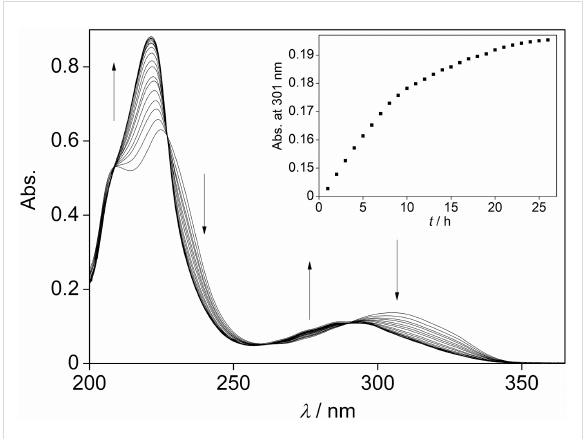
Figure 1: Photometric monitoring of the photoisomerization of 2-(1- naphthyl)norbornadiene ( 5b ) in MeCN, c = 20 µM, T = 20 °C, λ ex = 315 nm. The arrows indicate the development of the absorption bands with reaction time. Inset: Thermally induced back conversion of quadri- cyclane 6b into norbornadiene 5b at 60 °C as monitored by the increase of the norbornadiene absorbance at 301